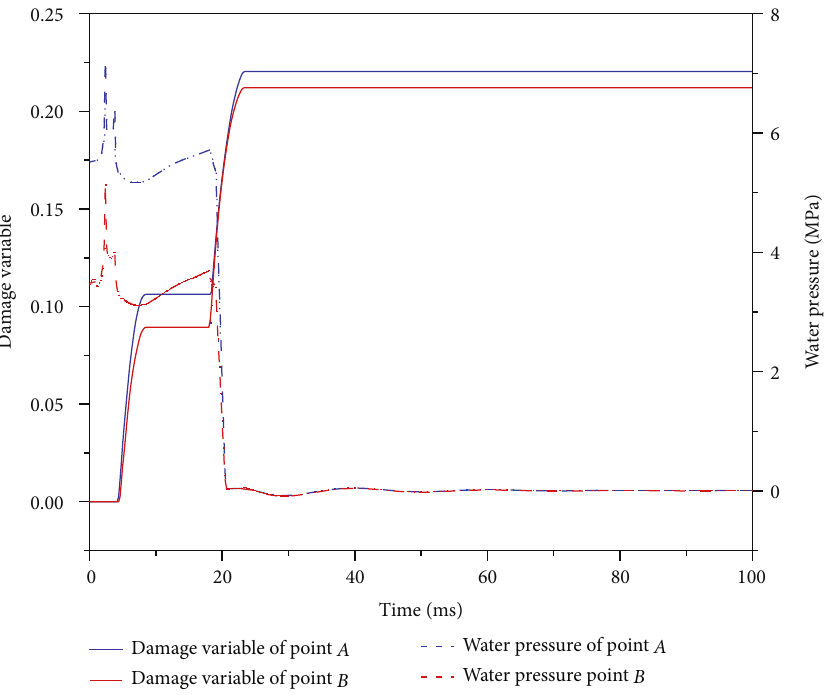
Figure 4: Time history curves of damage variable and water pressure at points A and B.